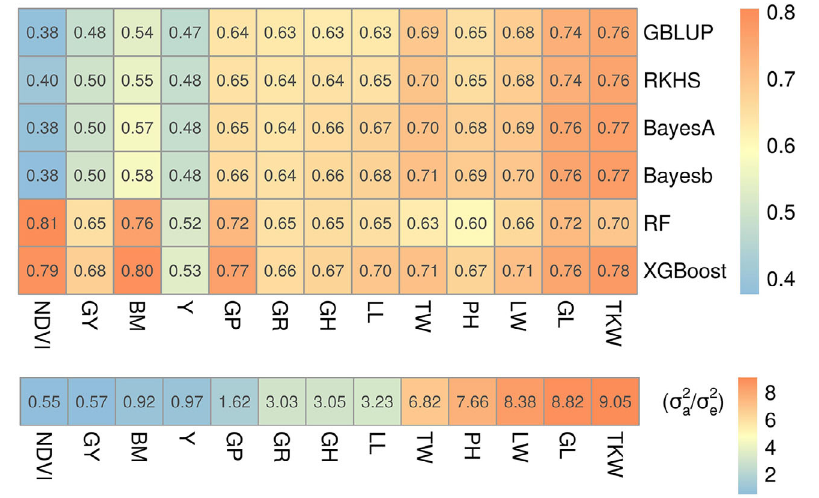
Figure3. Predictionaccuracies ofwheattraits. Top: predictionaccuraciesforGPmodels onwheattraits,reported as the mean Pearson correlation coefficient ( r ) of 5-fold cross-validation. Trait abbreviations are given in Table 2. Bottom: fraction of additive to residual genetic variance calculated using equation (9) for each trait. Traits were sorted in ascending order of additive variance fraction (left to right); therefore, the leftmost trait (NDVI) can be considered more complex than those to the